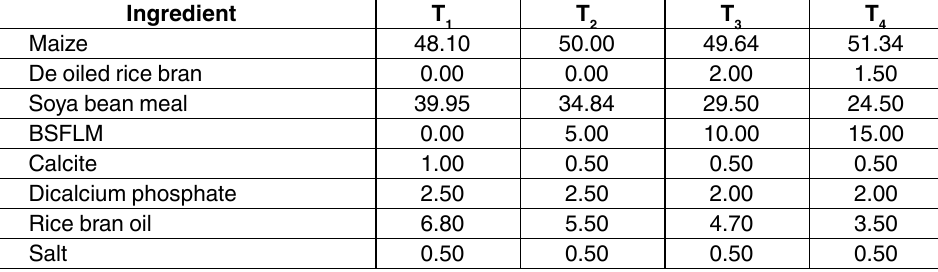
Table 2. Ingredient composition of starter diets, per cent